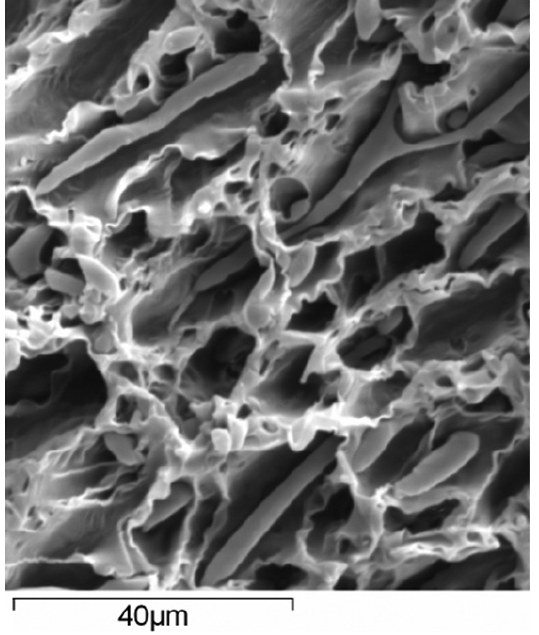
Figure 7. SEM micrographs of fractured surfaces of 90/10 LDPE/ PHB mixture.